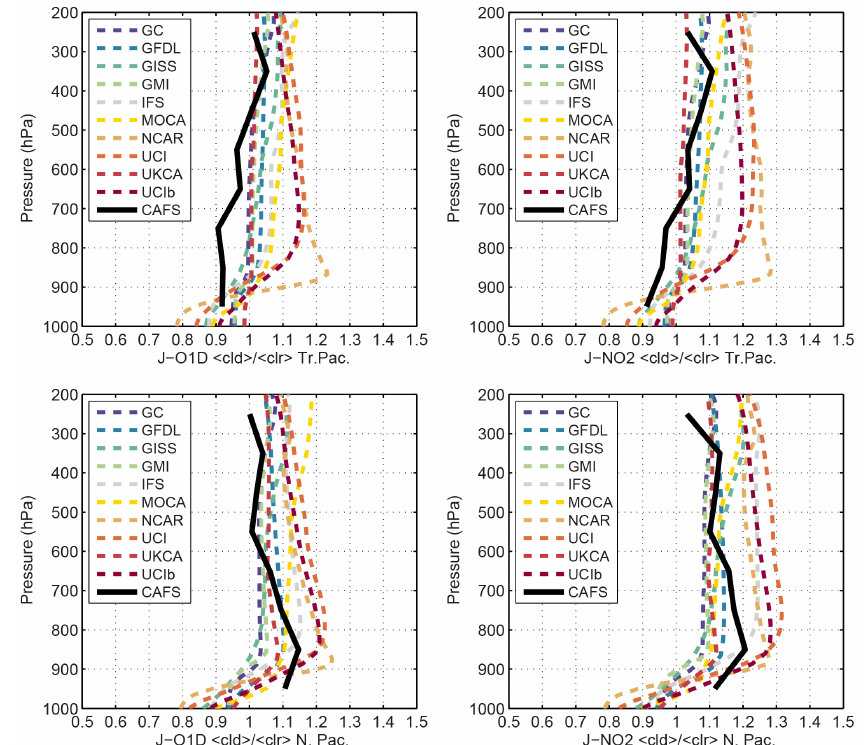
Figure 3. Profiles of the ratio of the average of J -cloudy to the average of J -clear for J -O1D and J -NO2 and for the two Pacific blocks. See Figs. 1 and